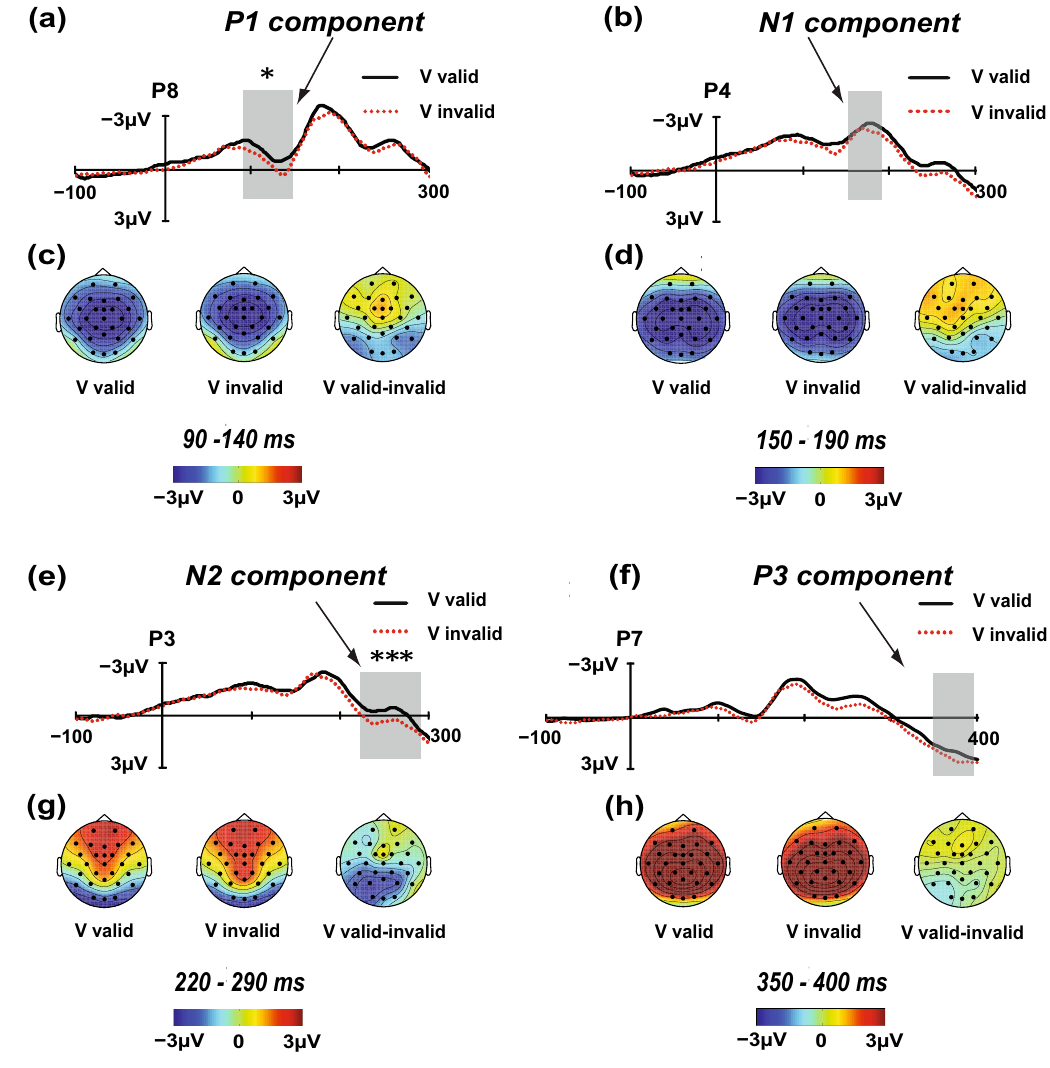
Figure 3. Direct comparisons of the visual IOR effect for the time windows 90–140 ms, 150–190 ms, 220– 290 ms, and 350–400 ms. The contrasts between the valid and invalid locations were analysed using t test (sig. two-tailed; 95% confidence interval, CI), and the maximum difference between the valid and invalid locations is shown from P4 electrode, and P7 electrode, for the N1 and P3 components, respectively. The difference between the valid and invalid locations for the P1 and N2 components reaches significance in the P8 electrode and P3 electrode, respectively (*p < 0.05; ***p < 0.001). The grand average amplitudes elicited by the V targets presented in either the valid (black solid) or invalid (red dotted) locations are shown from panels ( a ), ( b ), ( e ), and ( f ). The scalp topographies of the P1, N1, N2 and P3 components in the valid and invalid waveforms are shown in panels ( c ), ( d ), ( g ), and ( h ), respectively. Valid-invalid scalp topographies represent the IOR